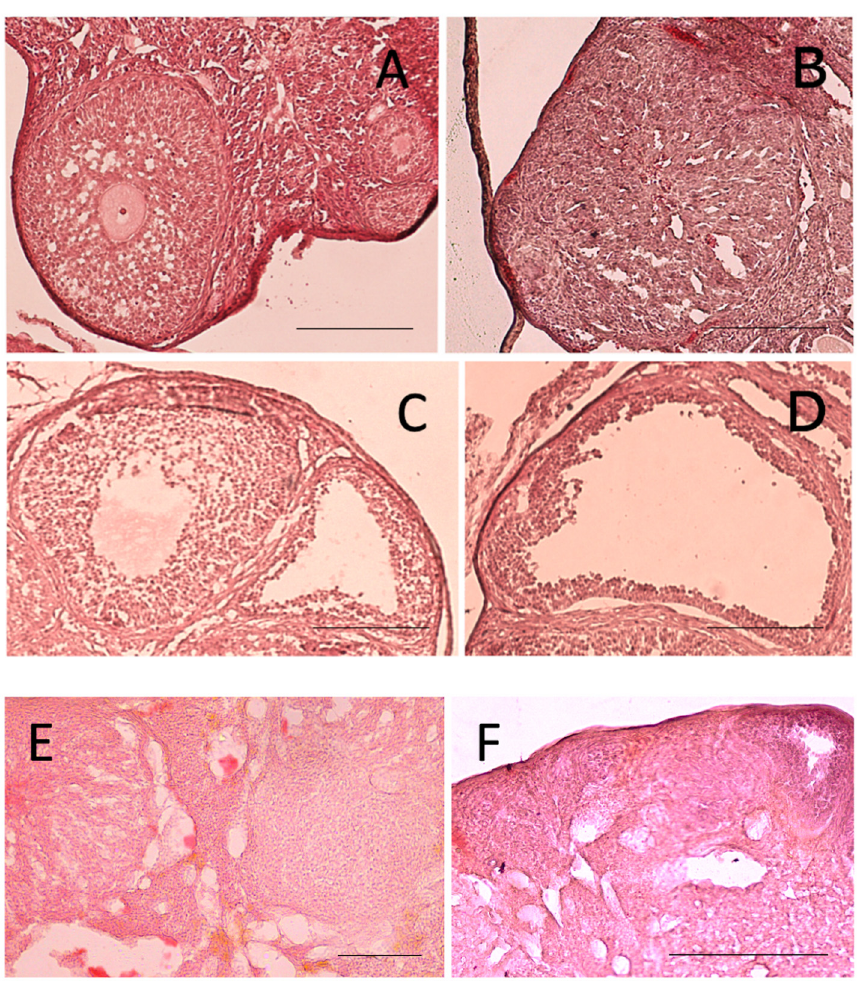
Figure 4. Histological features of mouse ovaries at the end of the 21 day-treatment. ( A , B ) Ovarian sections from mice that received plain water (negative control), showing a primary and a tertiary follicle ( A ) and a corpus luteum ( B ). ( C ) A section from a DCIns 250-treated mouse with cysts. ( D ) A section from a letrozole-treated mouse (positive control) with large cysts. ( E ) A section from a DCIns 500-treated mouse with follicular hyperproliferation. ( F ) A section from a DCIns 1000-treated mouse with stromal extension. Hematoxylin-eosin. Scale bars, 100 μ m.